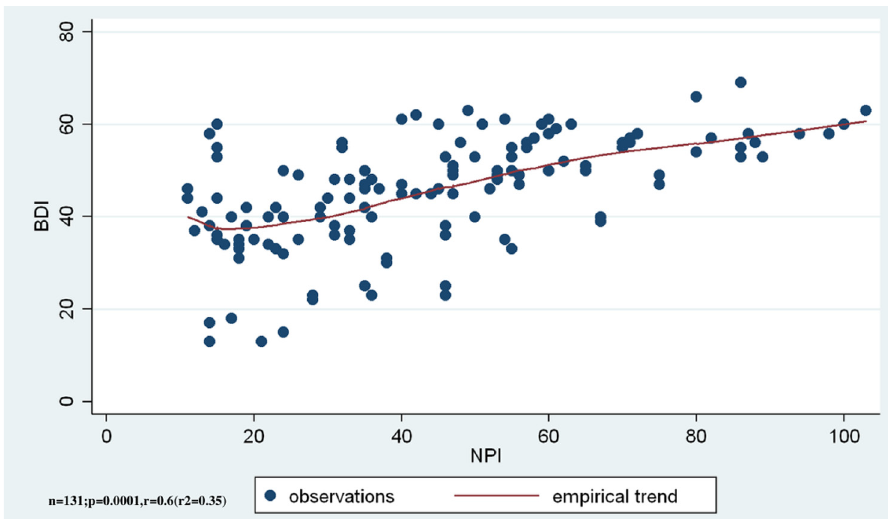
Figure 3: Illness intrusiveness shows signi fi cant positive correlation to the total score of NPSs.